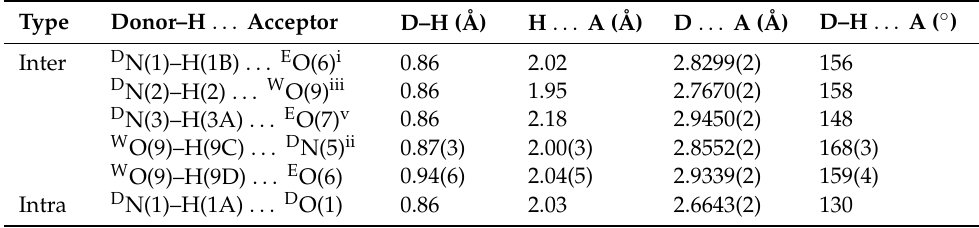
Table 2. Inter- and intra-molecular hydrogen bond in DBE monohydrate 1,2 .